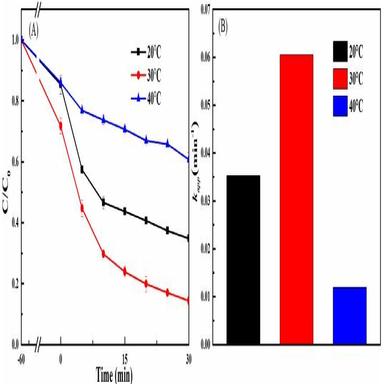
Effect of reaction temperature on the sonocatalytic degradation of RhB (A) and the corresponding Kapp values (B).